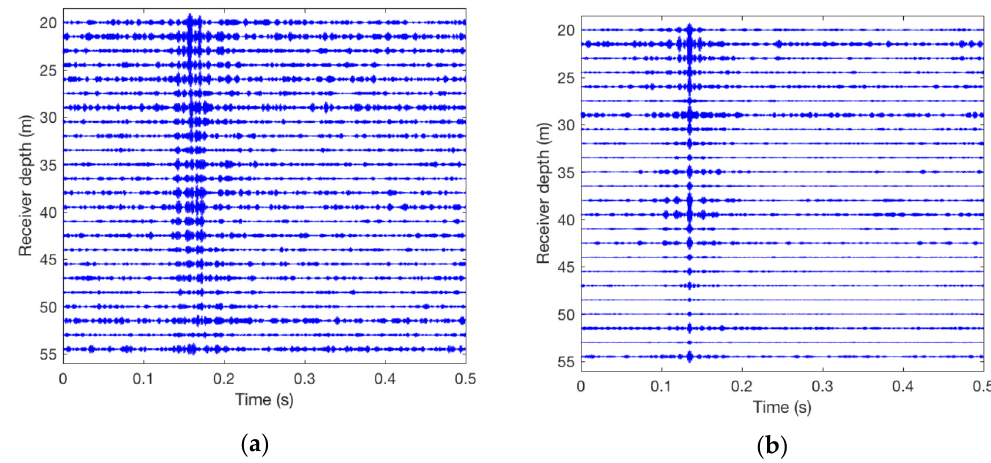
Figure 3. The channel responses received by the VRA from the PS at 40 m depth and 50 km range. ( a ) Before TR processing; ( b ) After TR processing.